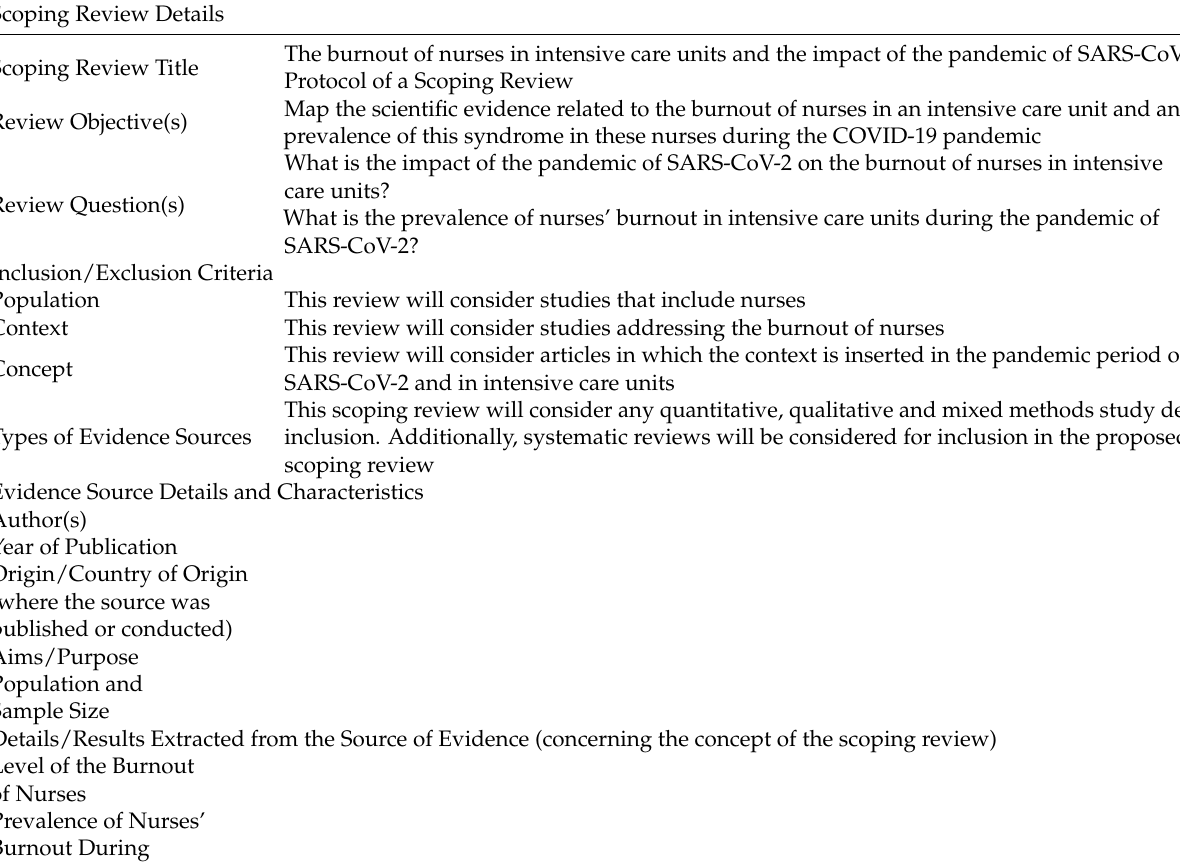
Table 2. Data extraction